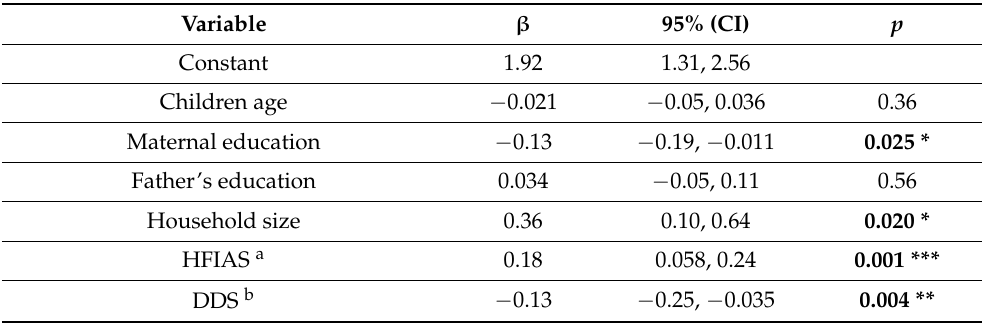
Figure 1. Urinary AFM1/Creat concentration of school children by age ( n = 408). In Table 2, the results from a best-fitting multiple regression model with twelve pre- dictor variables for creatinine-adjusted AFM1 concentration are presented. The model included selected socioeconomic variables, of which seven were significant predictors of uri- nary AFM1/Creat. Maternal education and higher child DDS predicted lower AFM1/Creat and the rest were positive predictors. For every additional increase in the level of ma- ternal education, there was an average reduction of 0.13 pg/mg in urinary AFMI/Creat concentration. For every increase in the number of household members, the AFM1/creat concentration increased by an average of 0.36 pg/mg. On the other hand, a unit increase in the frequency of haricot bean or cow’s milk consumption resulted in 0.087 pg/mg and 0.045 pg/mg increase of AFM1/creat level, respectively. There was an average reduction of AFMI/creat concentration by 0.13 pg/mg for every additional unit increase in DDS. As either the severity of household food insecurity increased or the source of drinking water increased by one unit, the concentration of AFM1/creat increased by 0.18 pg/mg and 0.11 pg/mg, respectively. Table 2. Multiple regression predicting urinary AFM1/creatinine (pg/mg) concentration of school age children ( n = 402).